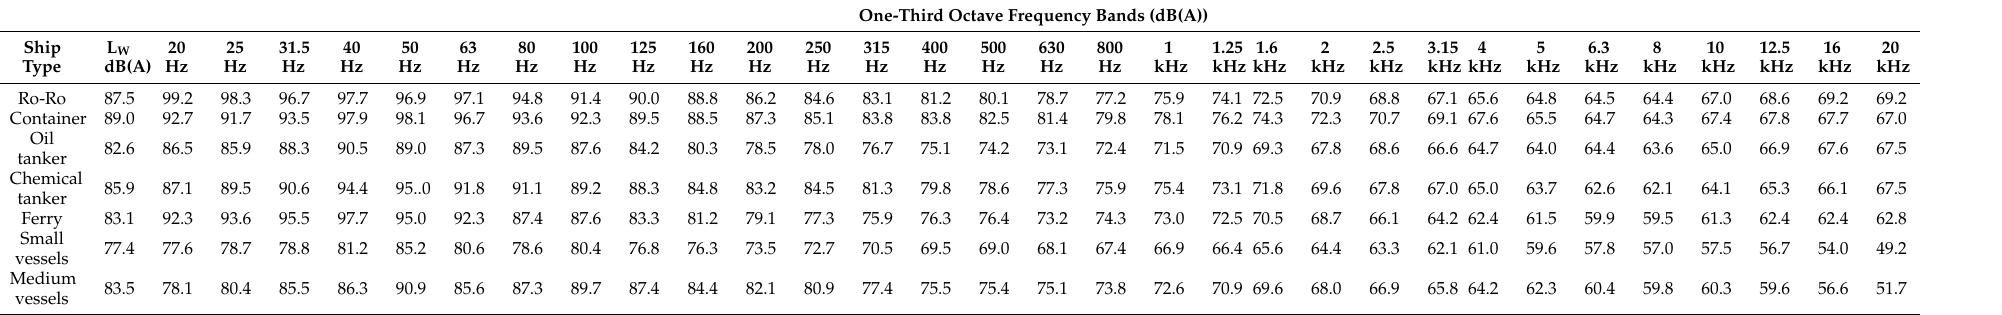
Table 11. One-third octave sound power spectra and sound power level of seagoing ships, as reported in [11,29,50]. Uncertainties can be retrieved from the original